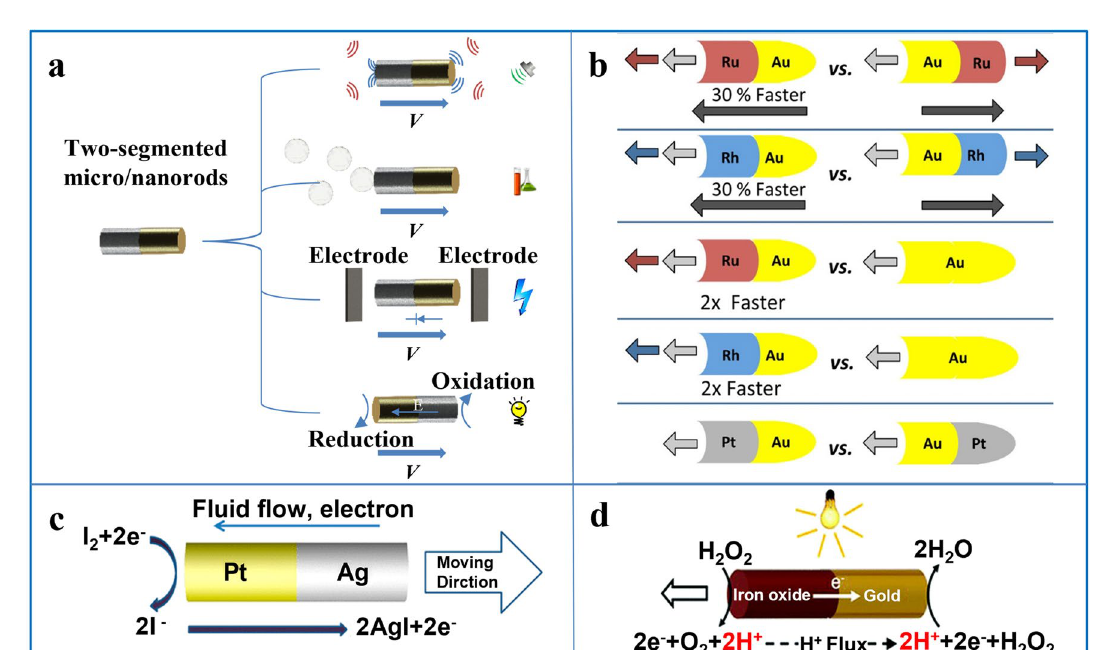
Fig. 4 a Two-segment nanorods driven in ultrasonic fields, chemical fuels, electric field and light. b Motion of Au/Ru Janus nanomotors in the ultrasound field. Reprinted with permission from Ref. [113]. Copyright (2016) American Chemical Society. c Pt/Ag Janus nanomotors generated from electrophoretic propulsion motors under illumination while regenerating the fuel. Reprinted with permission from Ref. [116]. Copyright (2016) American Chemical Society. d Driving mechanism of Fe 2 O 3 /Au Janus nanomotors in hydrogen peroxide environment. Reproduced with permission from Ref. [124]. Copyright (2017) Royal Society of